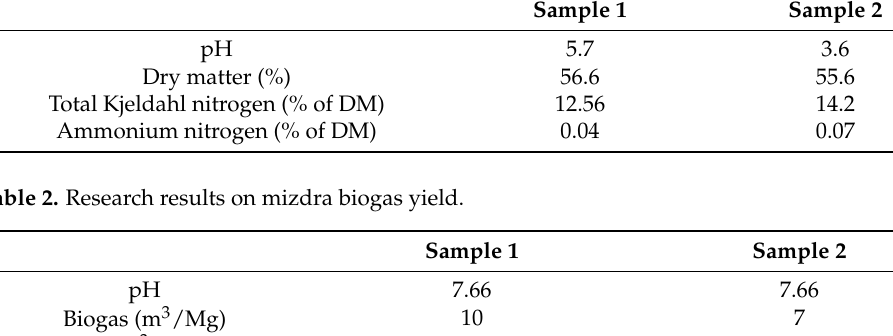
Table 1. Parameters of shaving waste.